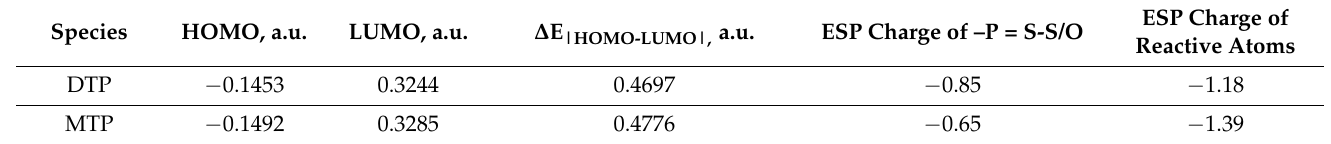
Table 7. Theoretical HOMO, LUMO, ∆ E |HOMO-LUMO| and ESP charge of a polar functional group. Species HOMO, a.u. LUMO,